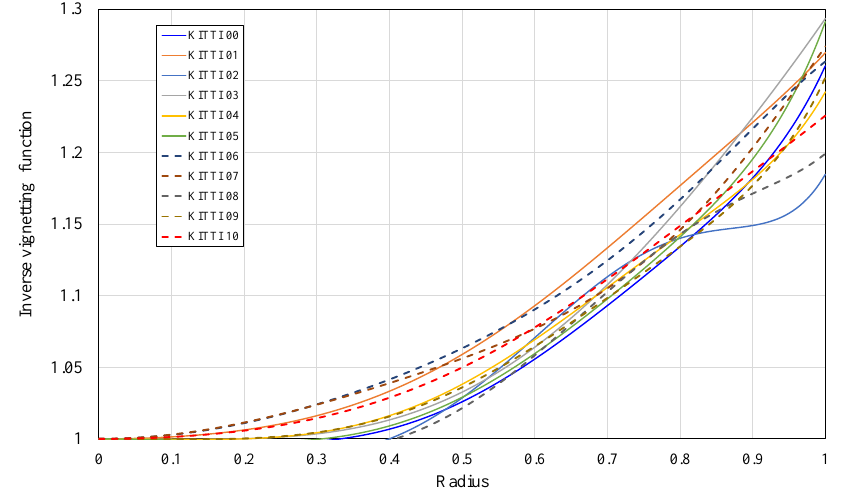
Figure 4. Inverse vignetting function versus radius of sequences 00 to 10 in KITTI